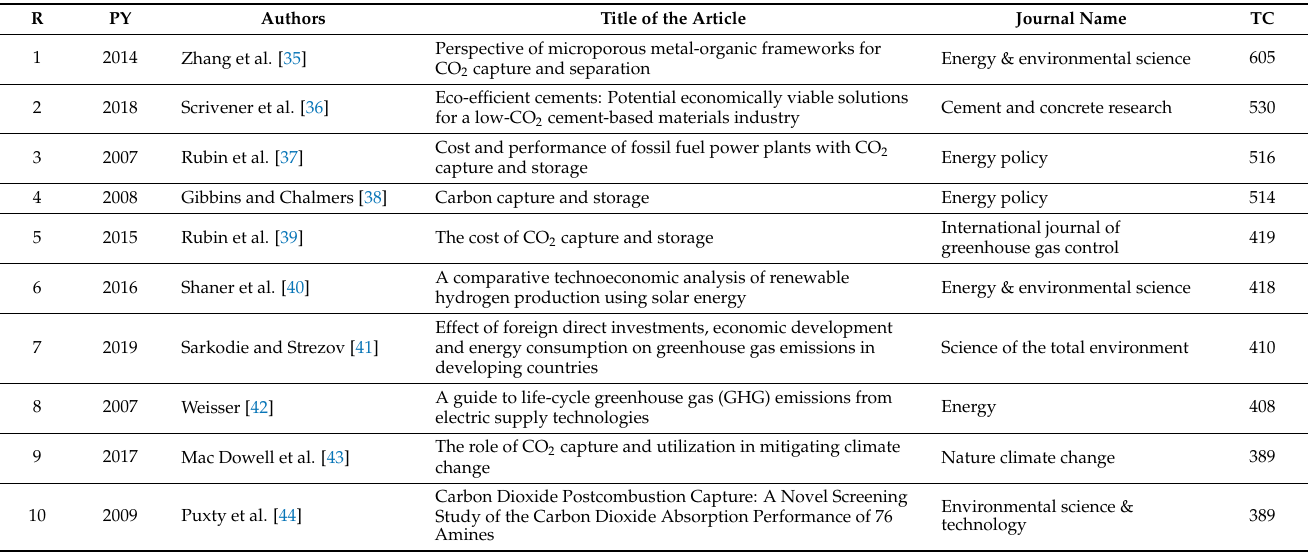
Table 6. Top ten most cited articles in carbon capture and utilization (based on total